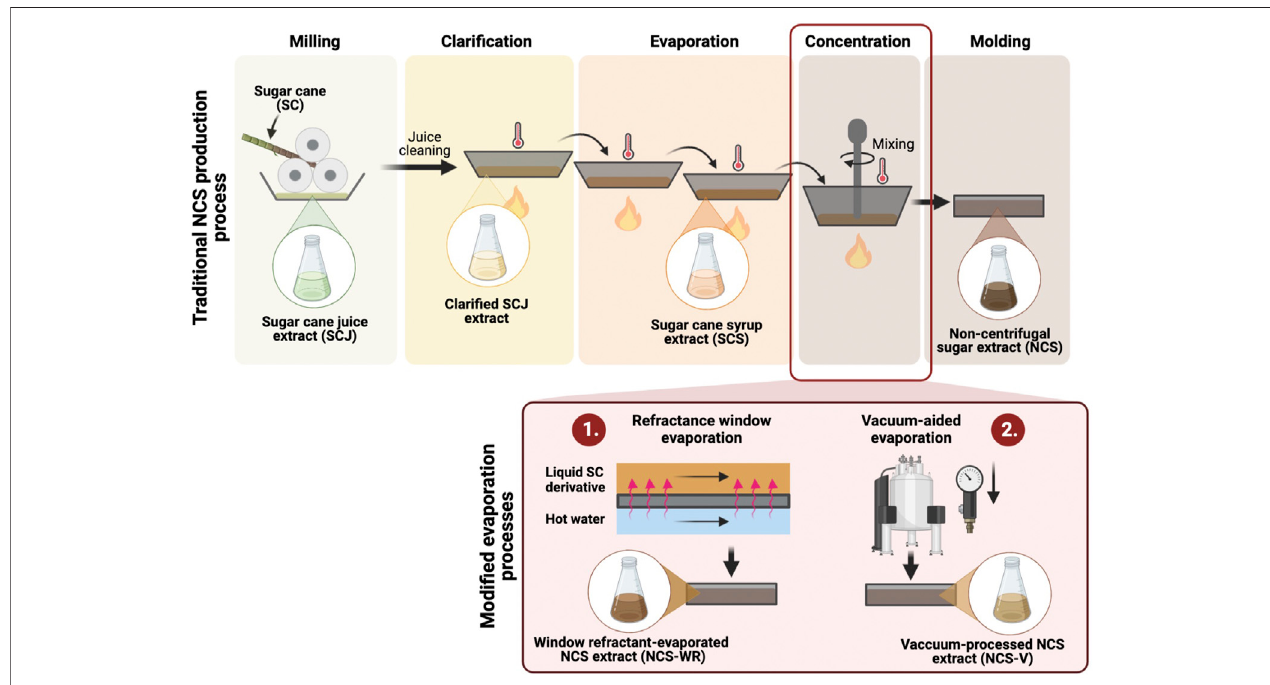
FIGURE1| GeneralschematicoftraditionalNCSproduction,aswellasthetwomodi fi edconcentrationprocessesthatemploy(1)refractancewindowevaporation and (2) vacuum-aided evaporation. Created with BioRender.com.